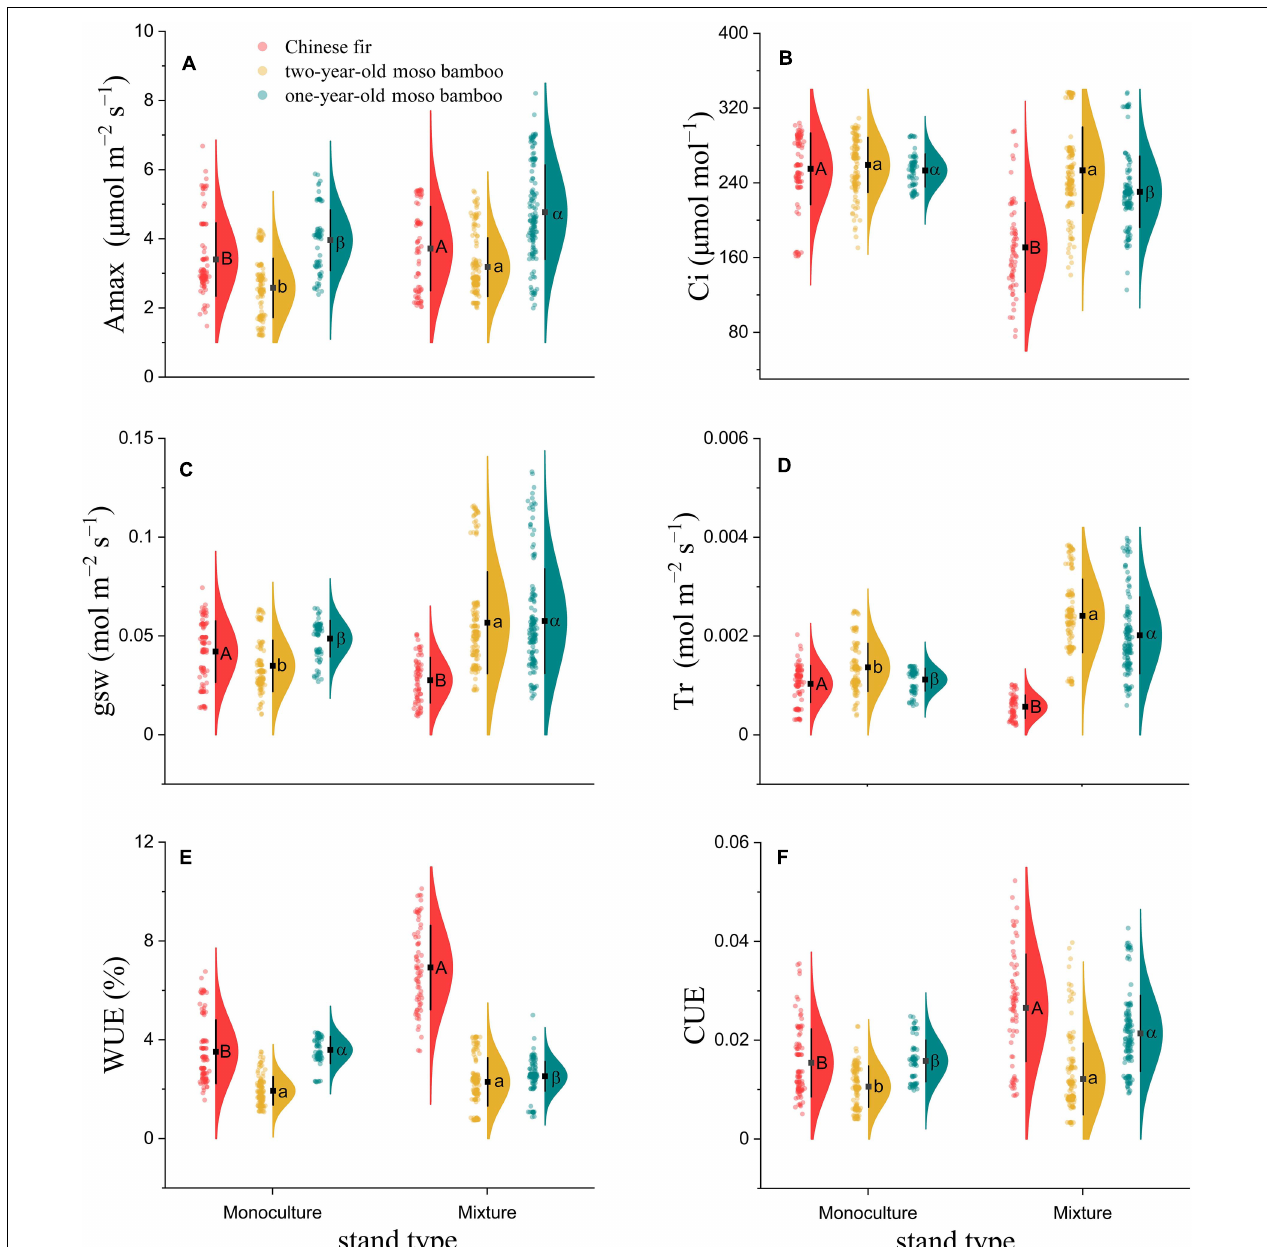
FIGURE 2 | Raincloud plot of photosynthetic parameters among (A) Amax, (B) Ci, (C) gsw, (D) Tr, (E) WUE, and (F) CUE combined. The “cloud” represents the data distribution, and the “rain” represents the jittered raw data. The black point represents the mean distribution values, and the black line represents the standard deviations of the distributions. Capital letters indicate significant differences between Chinese fir under monoculture and mixed-stand conditions ( P < 0.05). Lowercase letters indicate significant differences between 2-year-old moso bamboo under monoculture and mixed-stand conditions ( P < 0.05). Greek letters indicate significant differences between 1-year-old moso bamboo under monoculture and mixed-stand conditions ( P < 0.05).